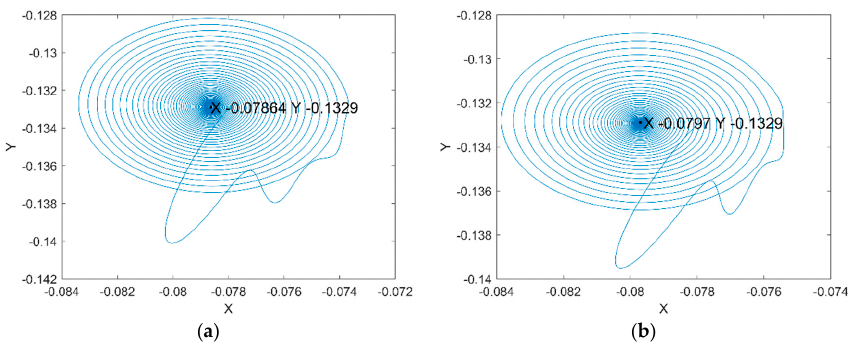
Figure 11. Rotor center trajectory at F e = 0.0987, M = 0.1071. ( a ) Without considering the UMF; ( b ) with considering the UMF.